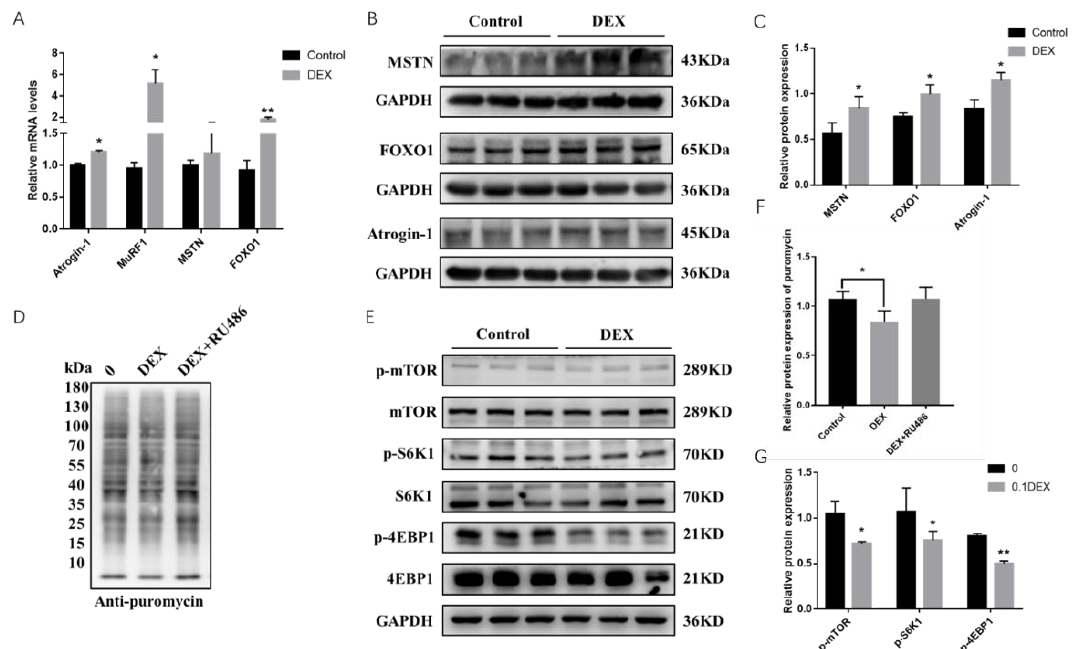
Figure 1. Glucocorticoids (GCs) increase protein breakdown and decrease protein synthesis in porcine skeletal muscle cells. ( A ) The mRNA expression levels of Atrogin-1 , MuRF1 , FOXO1 and MSTN treated with DEX; ( B ) the protein expression levels of Atrogin -1 , FOXO1 and MSTN treated with DEX; ( C ) quantification of Western blotting under the treatment of DEX; ( D ) effect of glucocorticoid and its antagonist on the protein synthesis rate; ( E ) the phosphorylation level of mTOR, S6K1 and 4EBP1 in mTOR signaling pathway after adding DEX; ( F ) quantification of protein synthesis rate under the treatment of DEX and RU486; ( G ) quantification of Western blotting under the treatment of DEX. *, ** indicate significant difference at p < 0.05 and p < 0.01, respectively.